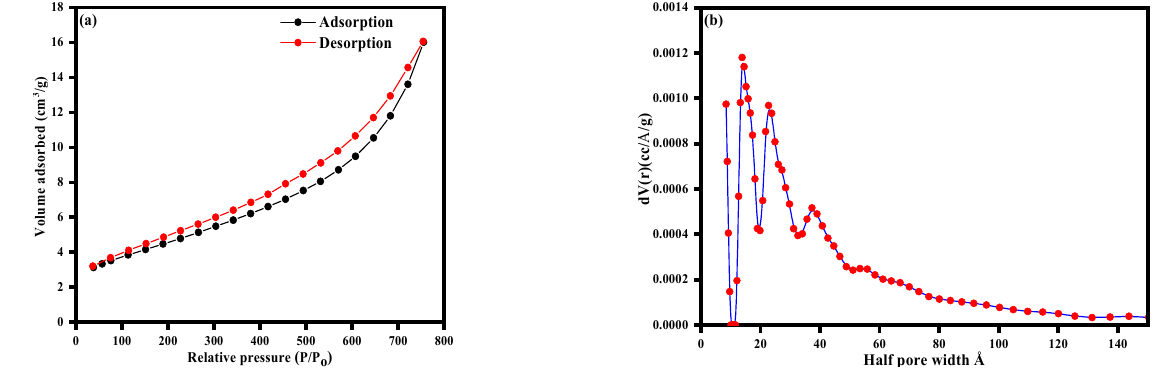
Figure 8. ( a ) Nitrogen adsorption/desorption isotherm plot and ( b ) micropore size distribution from the DFT model.